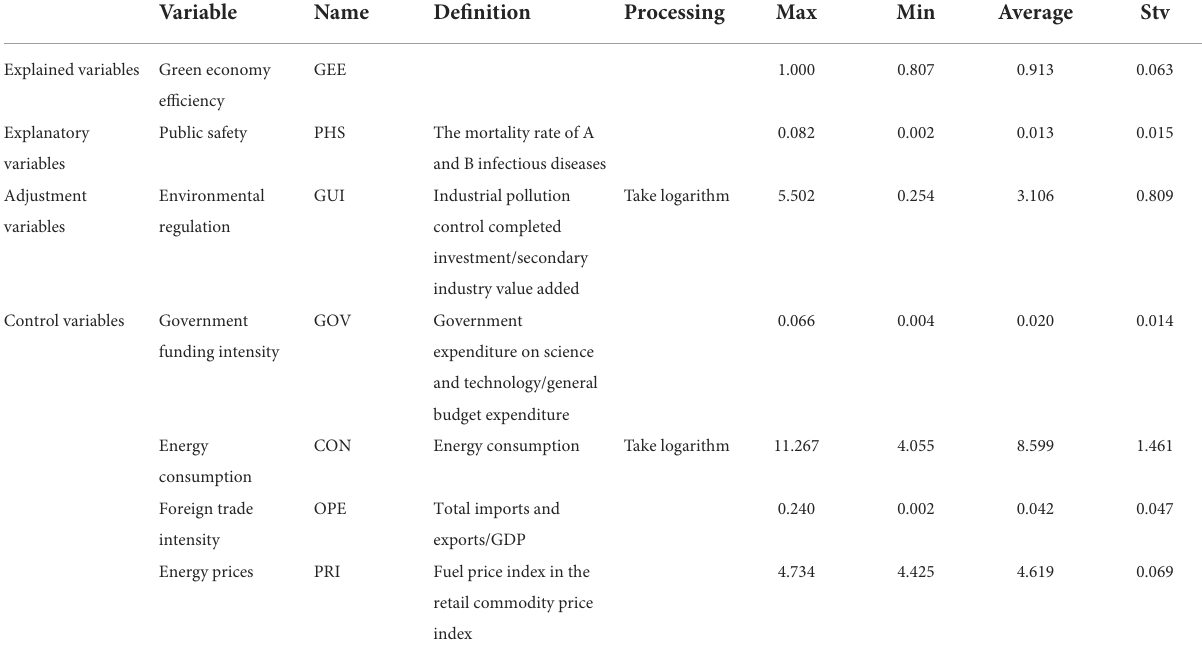
TABLE 2 Variable settings and descriptive